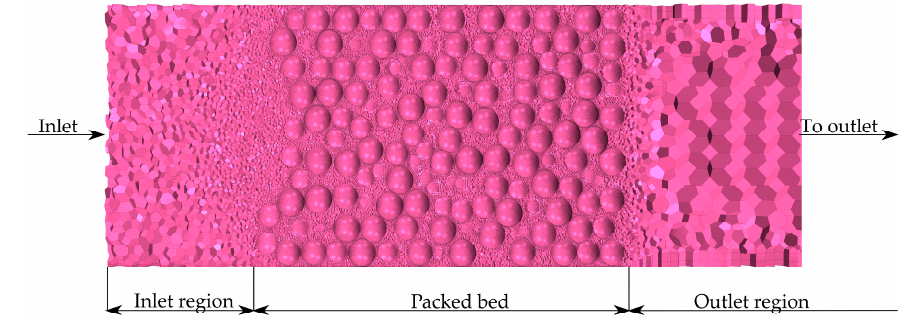
Figure 2. Mesh for radial porosity profiles and CFD simulations.